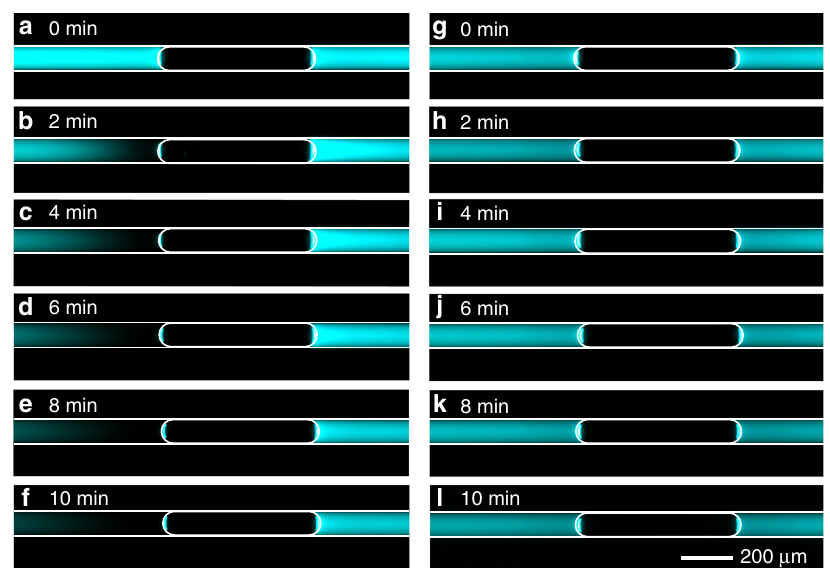
Fig. 4 Ion concentration polarization by fi lm nanochannel. a – f ICP effects were observed in 70 μ M STB solution, while not in 3 mM STB solution ( g – l ), with 30 μ M fl uorescein used as fl uorescence dye. The images were recorded every 2 min, to prevent the photobleaching of fl uorescence. White solid lines were drawn to outline the capillary and the position of the